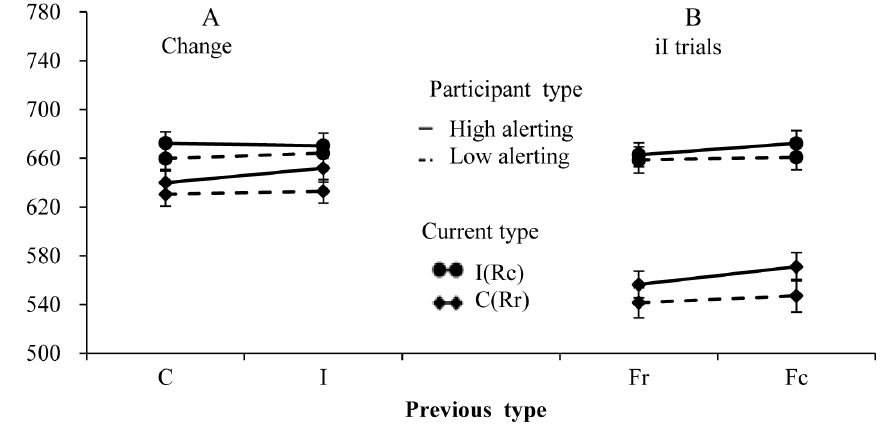
Figure 6. Mean RTs for each combination of current type and previous type of the two groups. Panel A shows the results on change trials of the high alerting level group and the low alerting level group. Panel B shows the results on the iI trials of the high alerting level group and the low alerting level group, respectively. NB. I = incongruent trials, C = congruent trials in panel A. Rc = response change, Rr = response repetition, Fr = flanker repetition, and Fc = flanker change in Panel B,